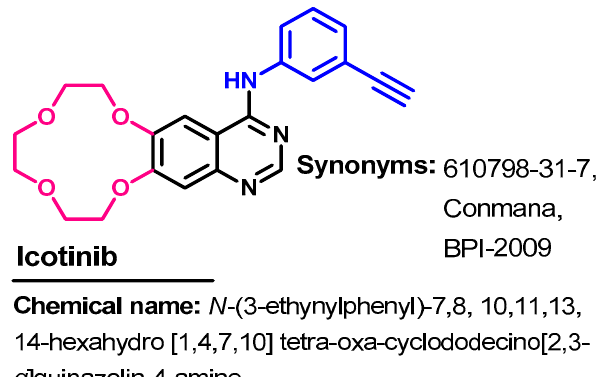
Figure 36. Chemical structure/name/synonyms of